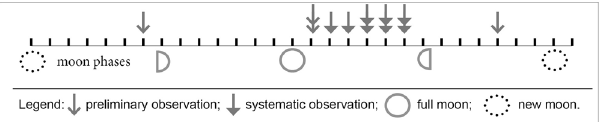
Figure 5. Observed synchronised spawning events by Lithophaga lithophaga in relation to the phases of the moon. Each arrow indicates when a spawning event at a given location was observed initially (Fig. 2). The exact observation times are identified in Table